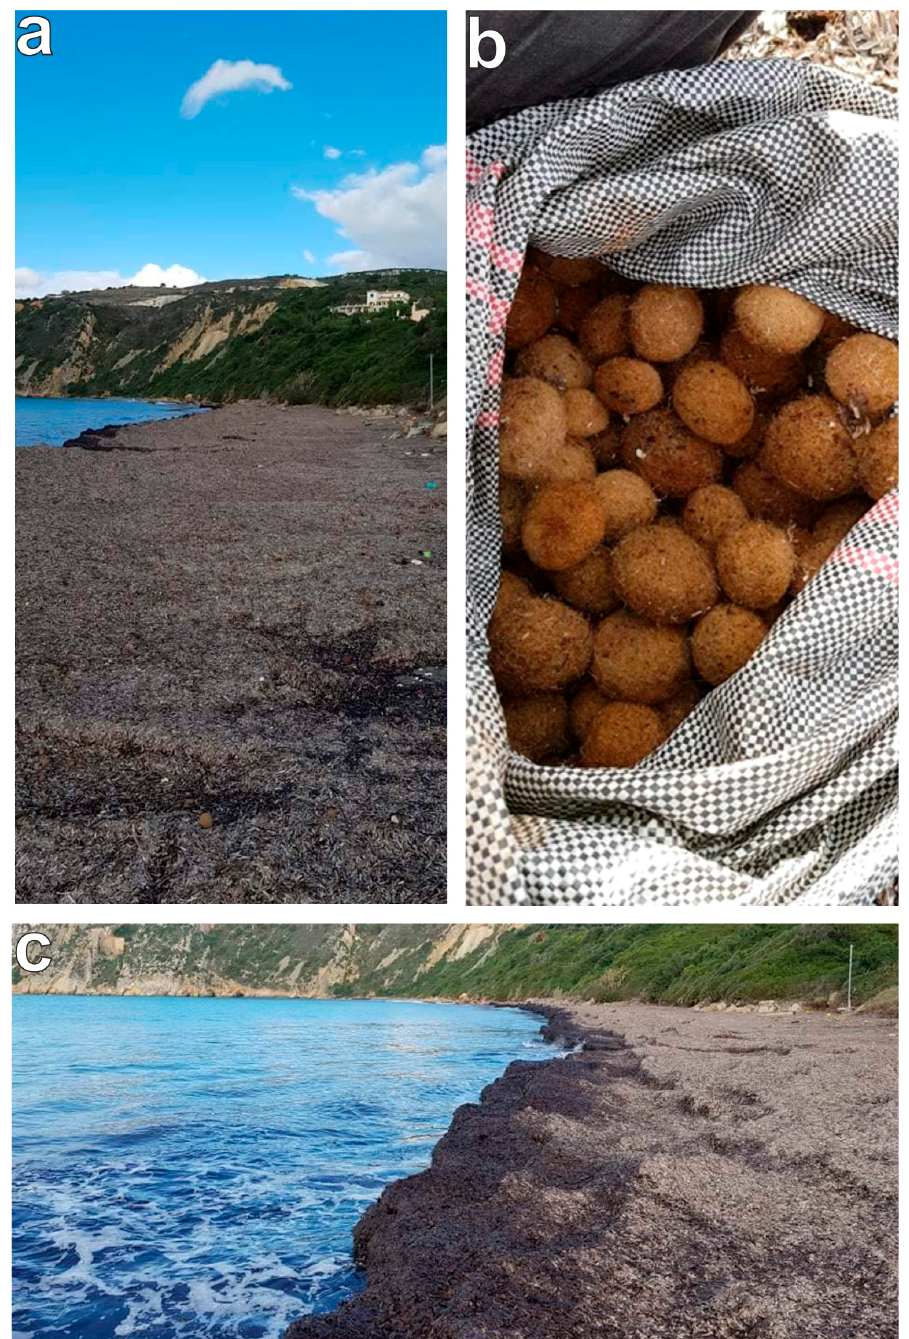
Figure 4. ( a – c ) Posidonia oceanica balls in Spasmata Beach (southwest part of Kefalonia